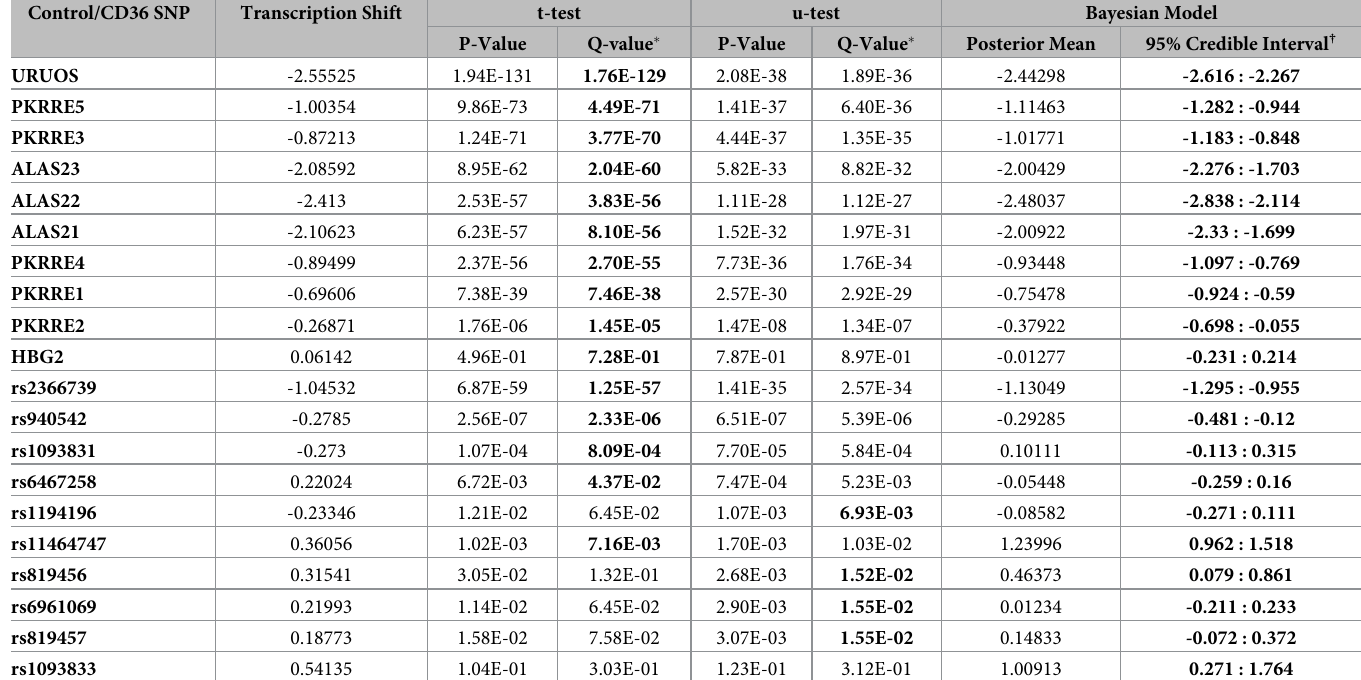
Fig 2. Design of the massively parallel reporter assay. A library of oligonucleotides was designed and synthesized containing CD36 eQTL SNPs surrounded by 150bp of genomic context 5’ to a KpnI/XbaI linker used to insert a minimal promoter- luciferase cassette derived from pNL3.2. 3’ to the linker is a unique 10bp barcode. SfiI restriction sites generated by PCR were used to clone the oligo into the pMPRA1 backbone vector. The plasmid library was transfected into K562 cells and 48 hours RNA was harvested. Barcodes from the harvested RNA and plasmid DNA library was quantified by NGS. https://doi.org/10.1371/journal.pgen.1008287.g002 significant MPRA hits identified by U-test (rs1193196 and rs819456), and the additional signif- icant MPRA hit identified by Bayesian analysis (rs1093833) by reporter assay. Reporter plas- mids containing reference or alternate alleles of the eQTLs were transfected into K562 cells and assayed after 48 hours for luciferase and β -gal expression. We first investigated the activity Table 2. MPRA-functional CD36